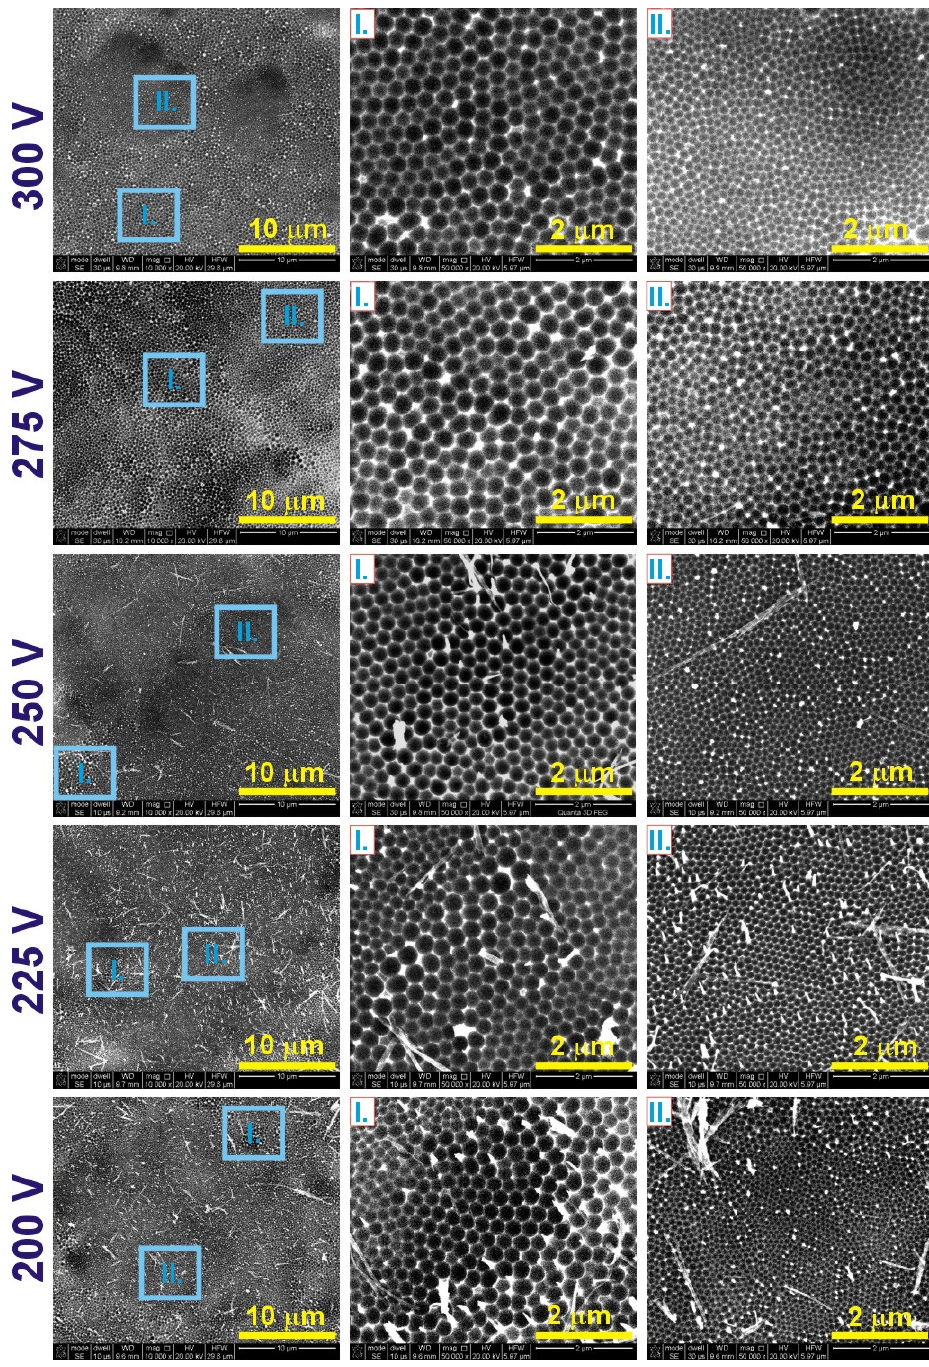
Figure 2. SEM images of the Al substrates after the dissolution of AAO obtained during anodization in 0.5 M glycolic acid solution at 5 °C. Table 1. Interpore distance ( D c ) in AAO produced in 0.5 Glycolic acid solution at 5 ◦ C and under different anodizing